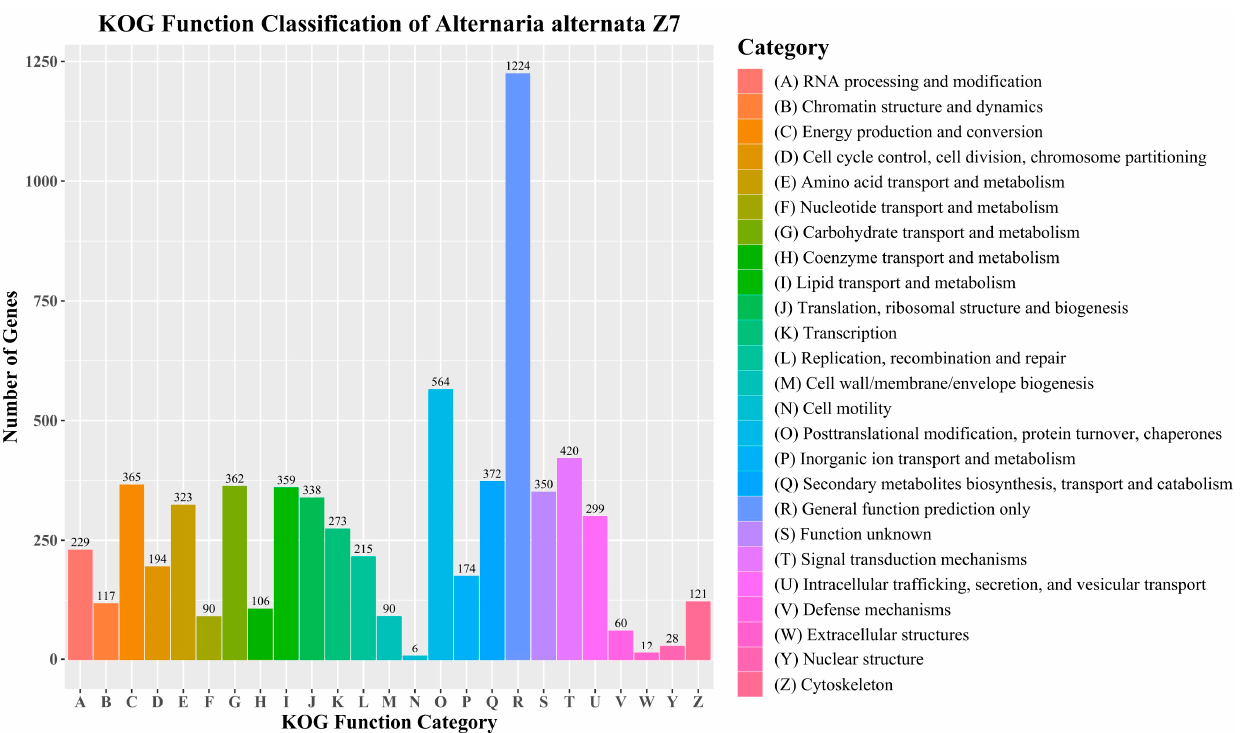
Figure 2. The x-axis of the KOG annotation of the global proteome in Alternaria alternata Z7 displays the KOG function classification of the consensus sequence, while the y-axis indicates the exact number of genes present in each functional class.